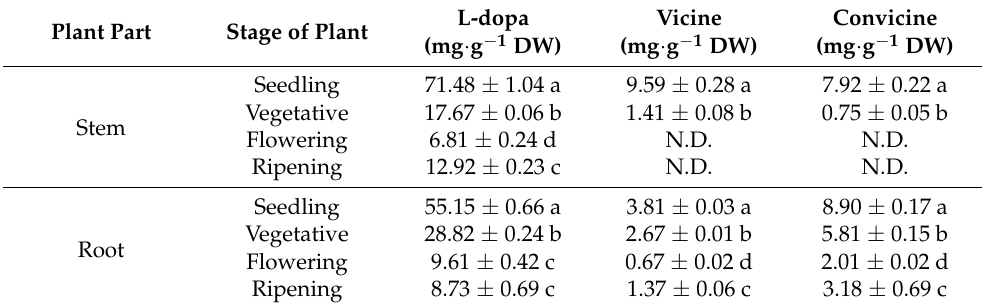
Table 2. L-dopa, vicine, and convicine contents in stems and roots during the four growth stages of faba bean